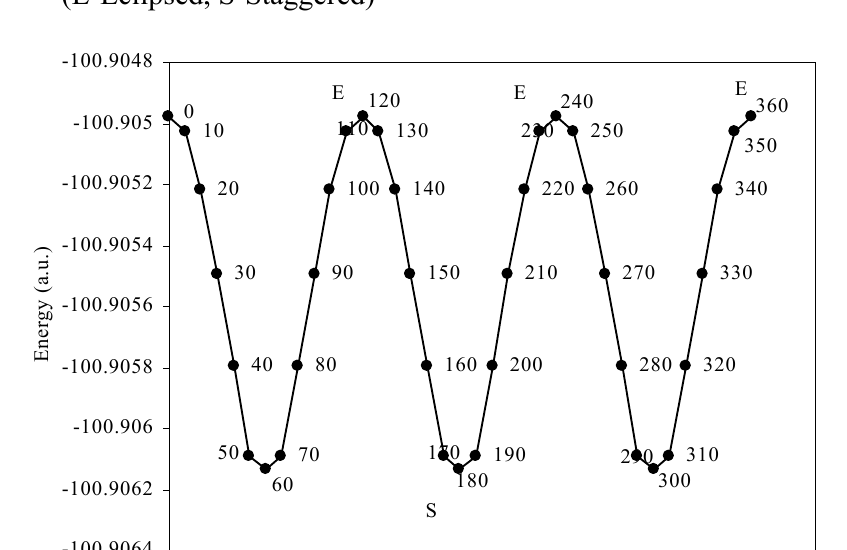
B-NH system as a function of torsional angles 3 3